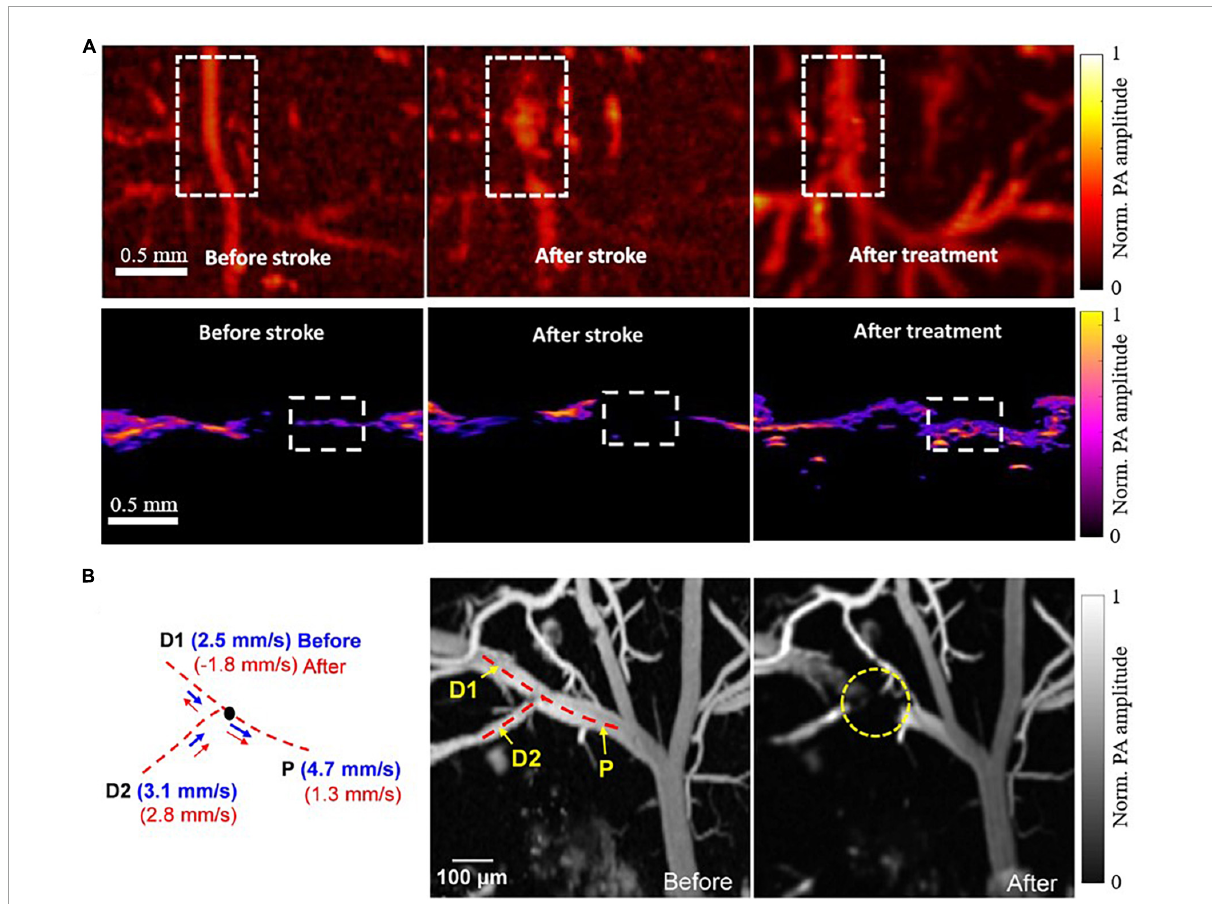
FIGURE2 PAI of single vessel occlusions (Lin et al., 2017; Cai et al., 2022). (A) PAM (top row) and PACT (bottom row) images of a blood vessel before PT stroke, after PT stroke, and after experimental tPA treatment, acquired at 720nm. (B) PAM images of a blood vessel before and after PT stroke acquired at 532nm with corresponding blood flow velocity calculations on the left. P indicates the parent vessel of the clot, with D1 and D2 indicating two branching daughter